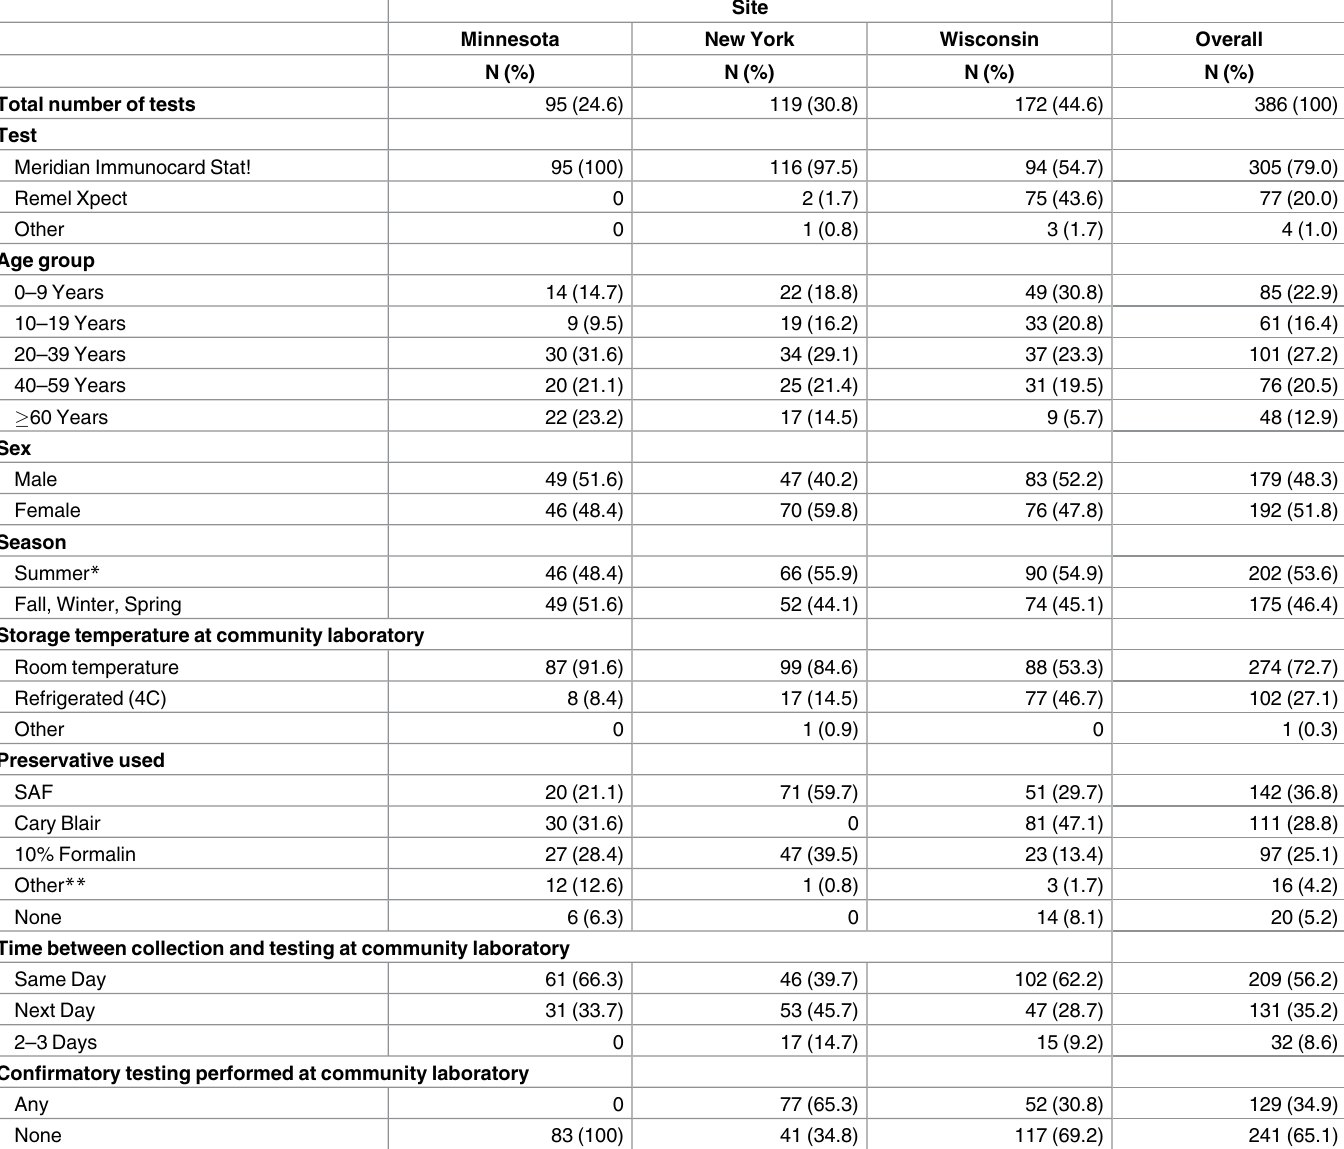
Table 1. Characteristics of stool specimens that tested positive for Cryptosporidium infection by rapid cartridge assay at community laboratories, by study site and